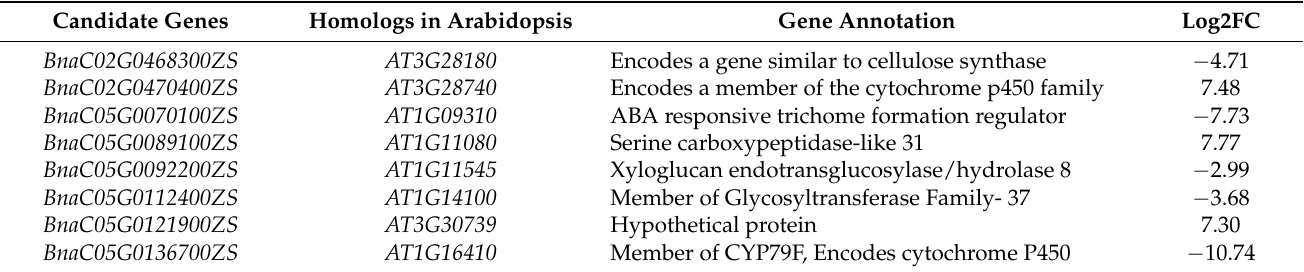
Table 4. Differentially expressed genes in the associated region of hemicellulose content in rapeseed stalk.